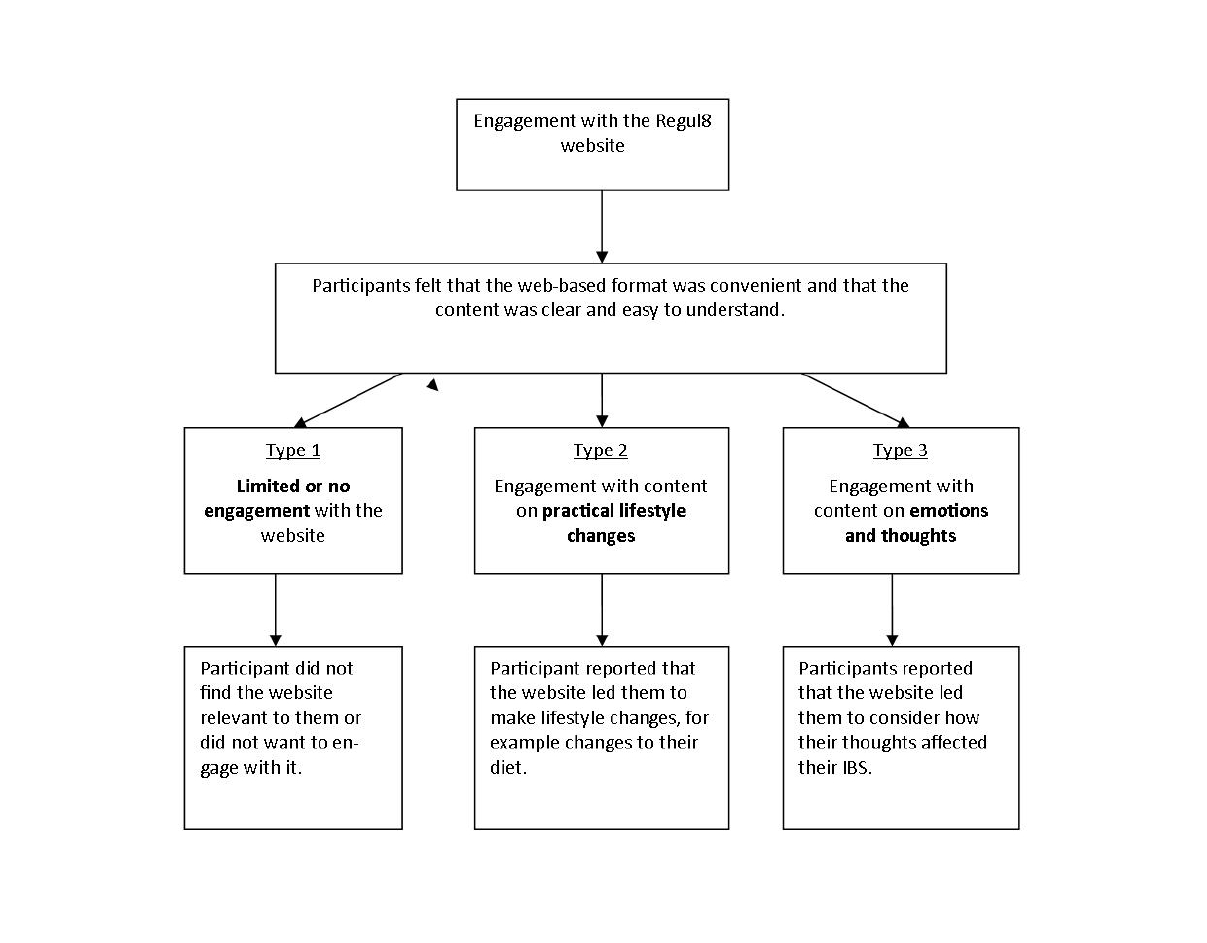
Figure 3. Thematic map identifying the 3 types of patient engagement with the Regul8